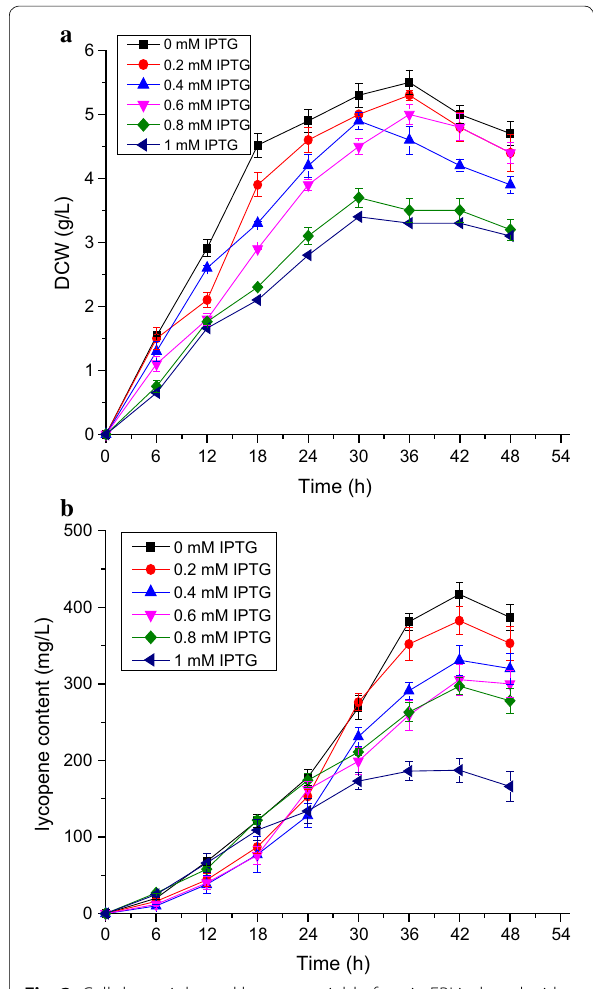
Fig. 3 Cell dry weight and lycopene yield of strain EBI induced with different IPTG concentrations. a Cell dry weight of EBI in LB medium with the addition of 0–1 mM IPTG at 30 °C for 48 h. b Lycopene production of EBI in LB medium with the addition of 0 to 1 mM IPTG at 30 °C for 48 h. The data represent the means of three independent experiments. Error bars represent standard